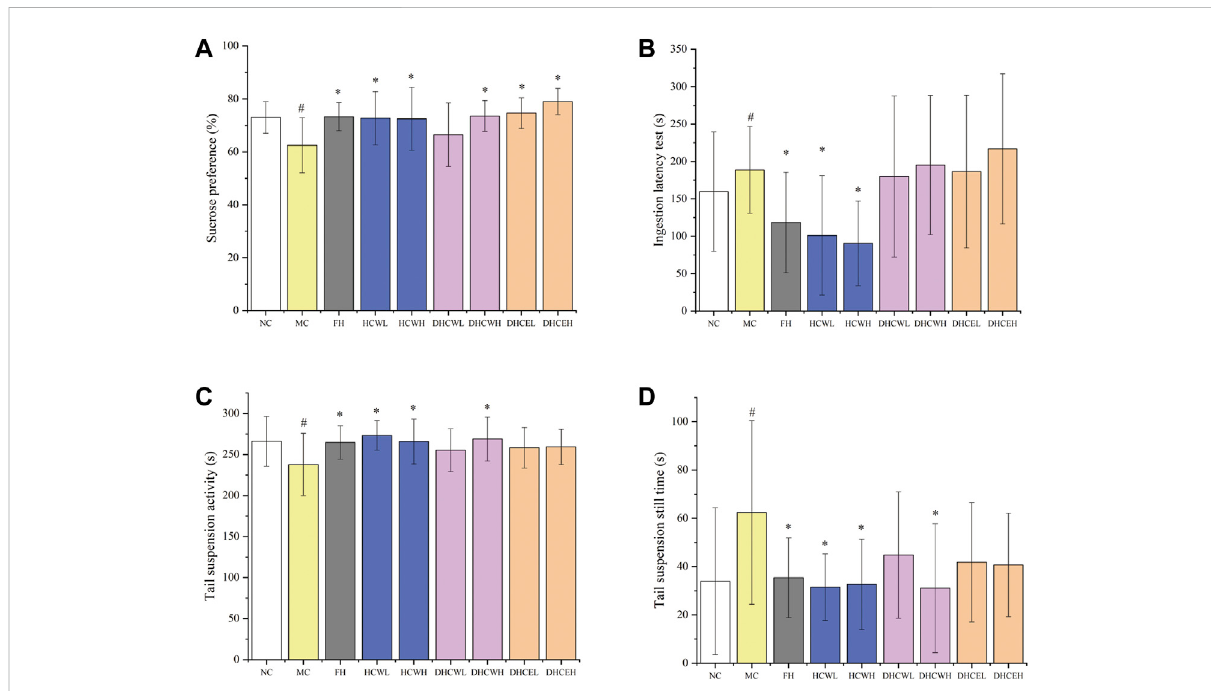
Theeffectsofdifferentdoseextractsof H.citrina fl owersanddried fl owerbudsonthebehaviorsofCUMSmice. (A) Sucrosepreferencetest, (B) ingestion latency test, (C) tail suspension activity test, and (D) tail suspension still time test. Data are reported as mean ± SD. For statistical signi fi cant, # p < 0.05, ## p < 0.01comparedwiththenormalcontrolgroup;* p < 0.05,** p < 0.01comparedwiththemodelcontrolgroup.NC,normalgroup;MC, model group; FH, Fluoxetine hydrochloride group; HCWL and HCWH, low and high-dose of water extracts of fl owers; DHCWL and DHCWH, lowandhigh-doseofwaterextractsofdried fl owerbuds;DHCELandDHCEH:lowandhigh-doseof80%ethanolextractsofdried fl owerbuds;low- dose, 200 mg/kg; high-dose, 500